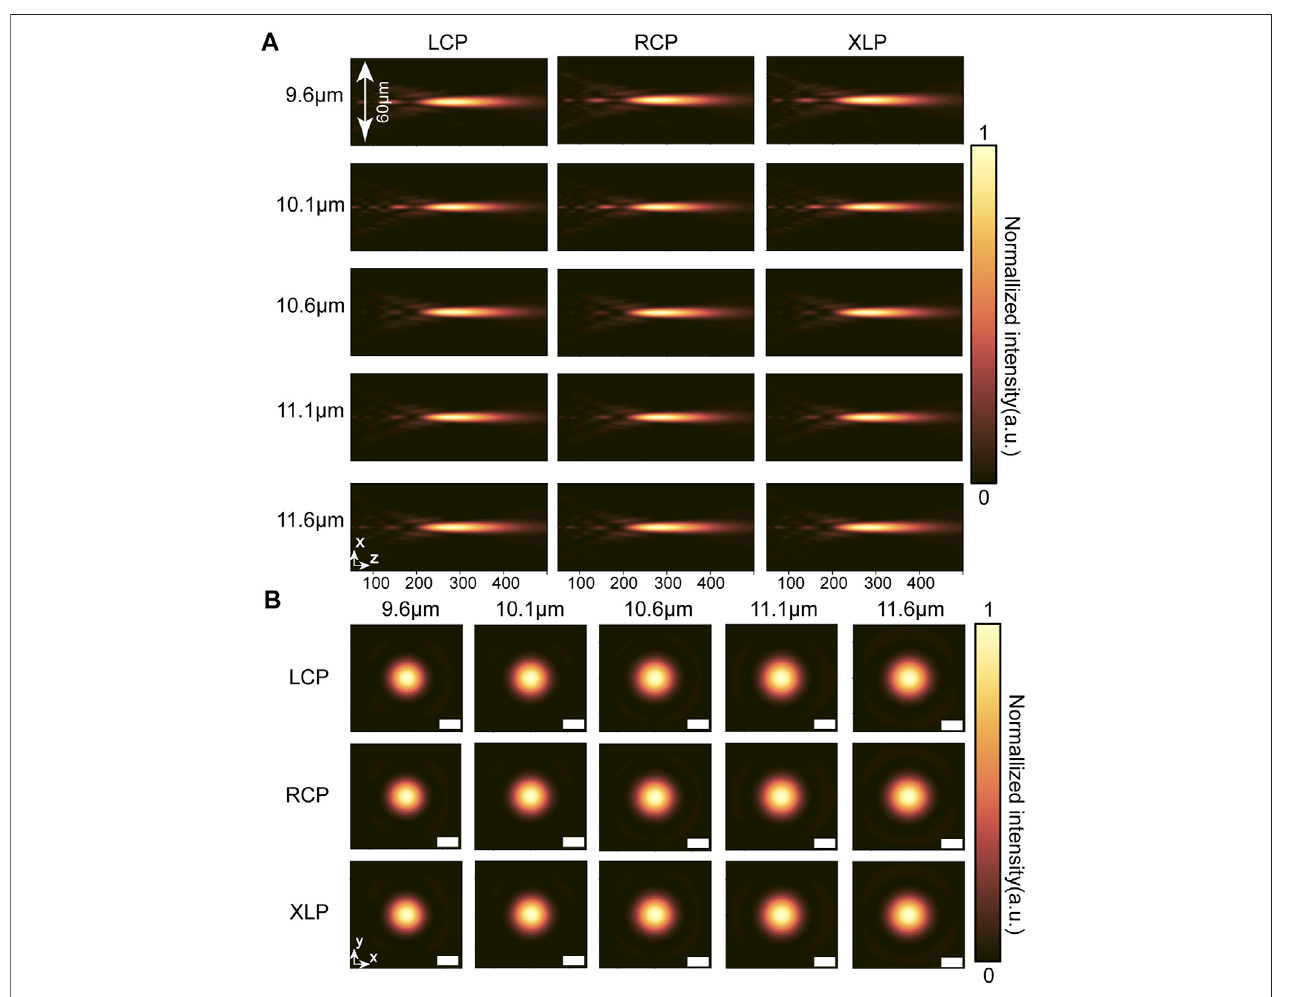
FIGURE 4 | Intensity distribution of the broadband achromatic metalens. (A) Intensity pro fi les in the x-z plane at selected wavelengths. From left to right, each columncorrespondstoLCPincidence,RCPincidence,andXLPincidence. (B) Intensitydistributionatthefocalplaneatselectedwavelengths.Fromtoptobottom,each column corresponds to LCP incidence, RCP incidence, and XLP incidence. Scale bar is 10